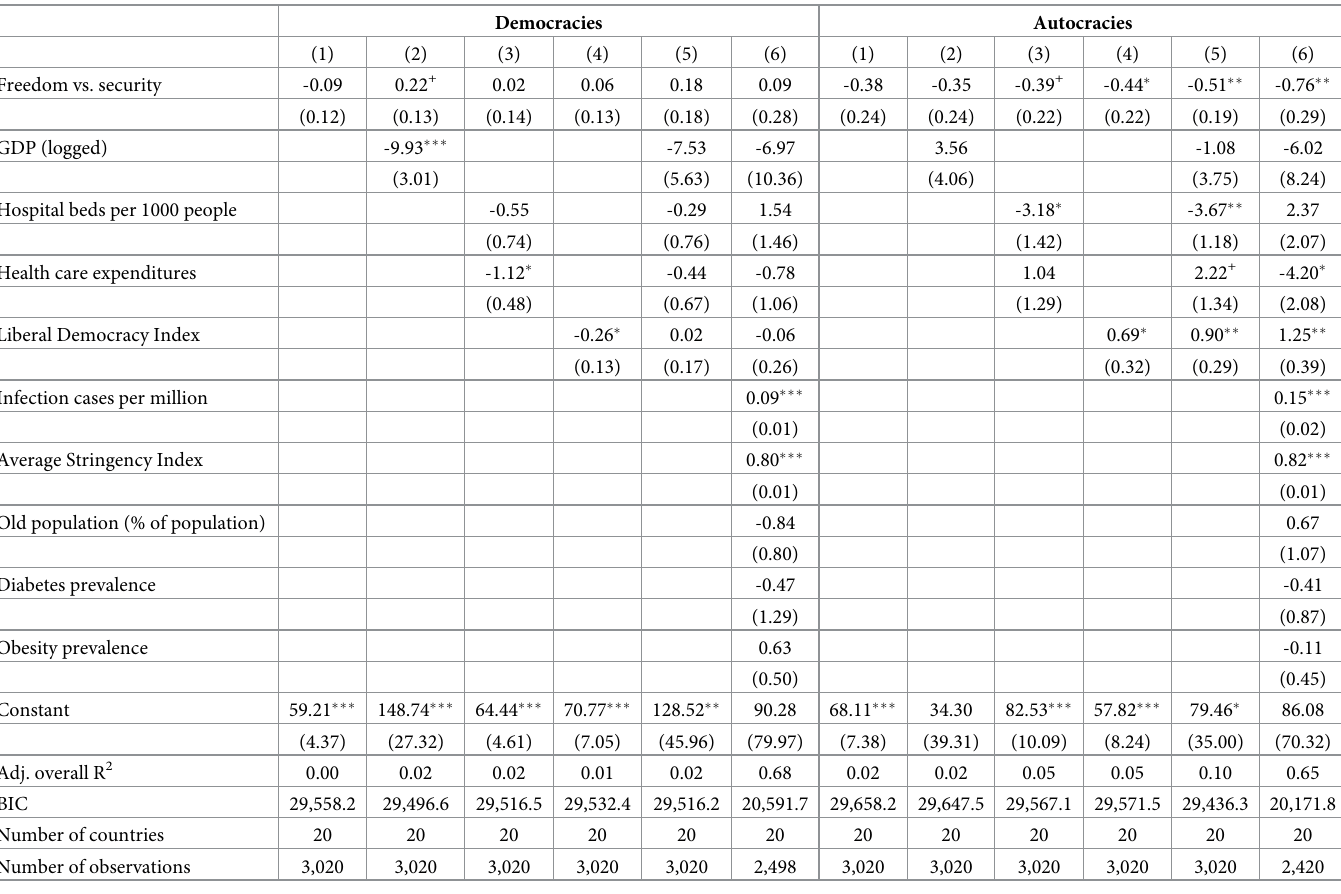
Table 3. Random effects models for the Stringency Index, democracies (n = 20) and autocracies (n = 20).